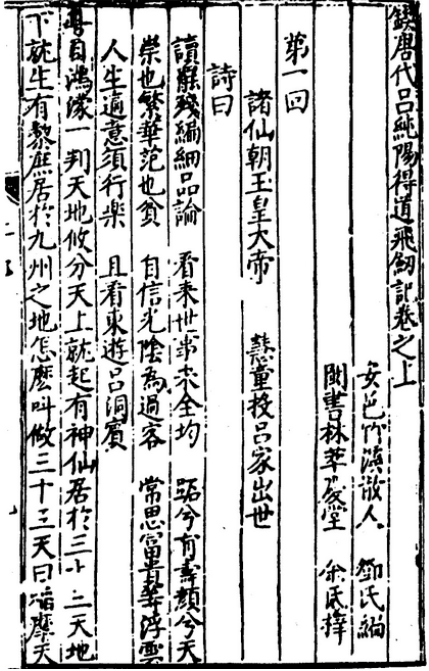
Figure 2 First page of The Flying Sword .